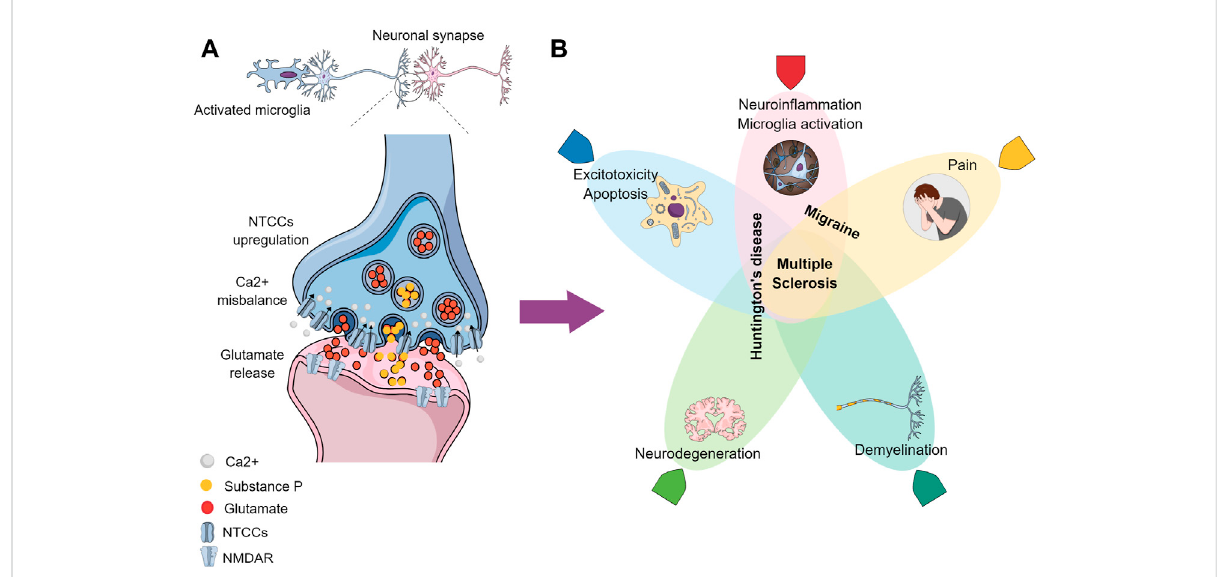
FIGURE 1 Graphical conclusion. (A) Activated microglia contribute to the increased neuronal excitability, where the NTCCs are presynaptically upregulated, causing a Ca 2+ misbalance in fl ux and an excessive neurotransmitters release (like glutamate and Substance P) in the synaptic cleft, which is propagated postsynaptically, due to the NMDAR excessive activation. (B) Processes/conditions resulting from the altered signaling have been demonstrated in (A) , where the overlapped zones represent similarities between the different neurological diseases: Migraine, Huntington ’ s disease, and Multiple